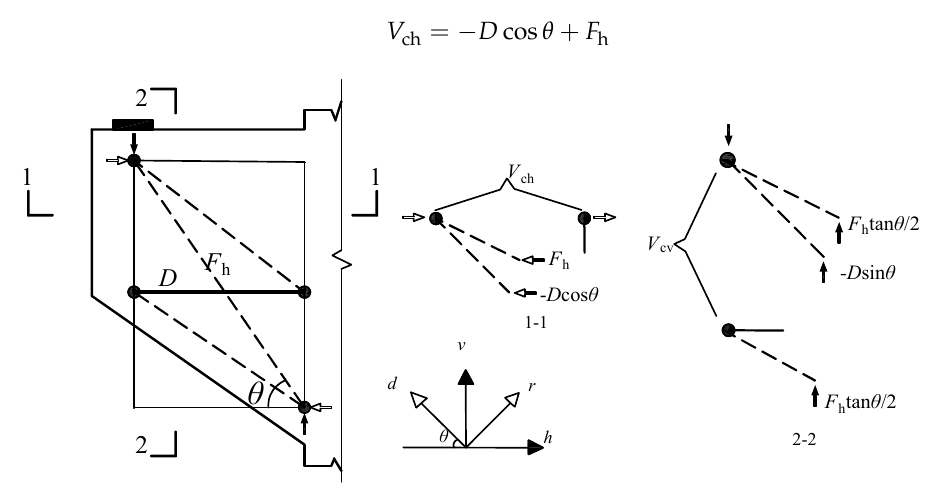
Figure 5. Forces in the strut-and-tie model .